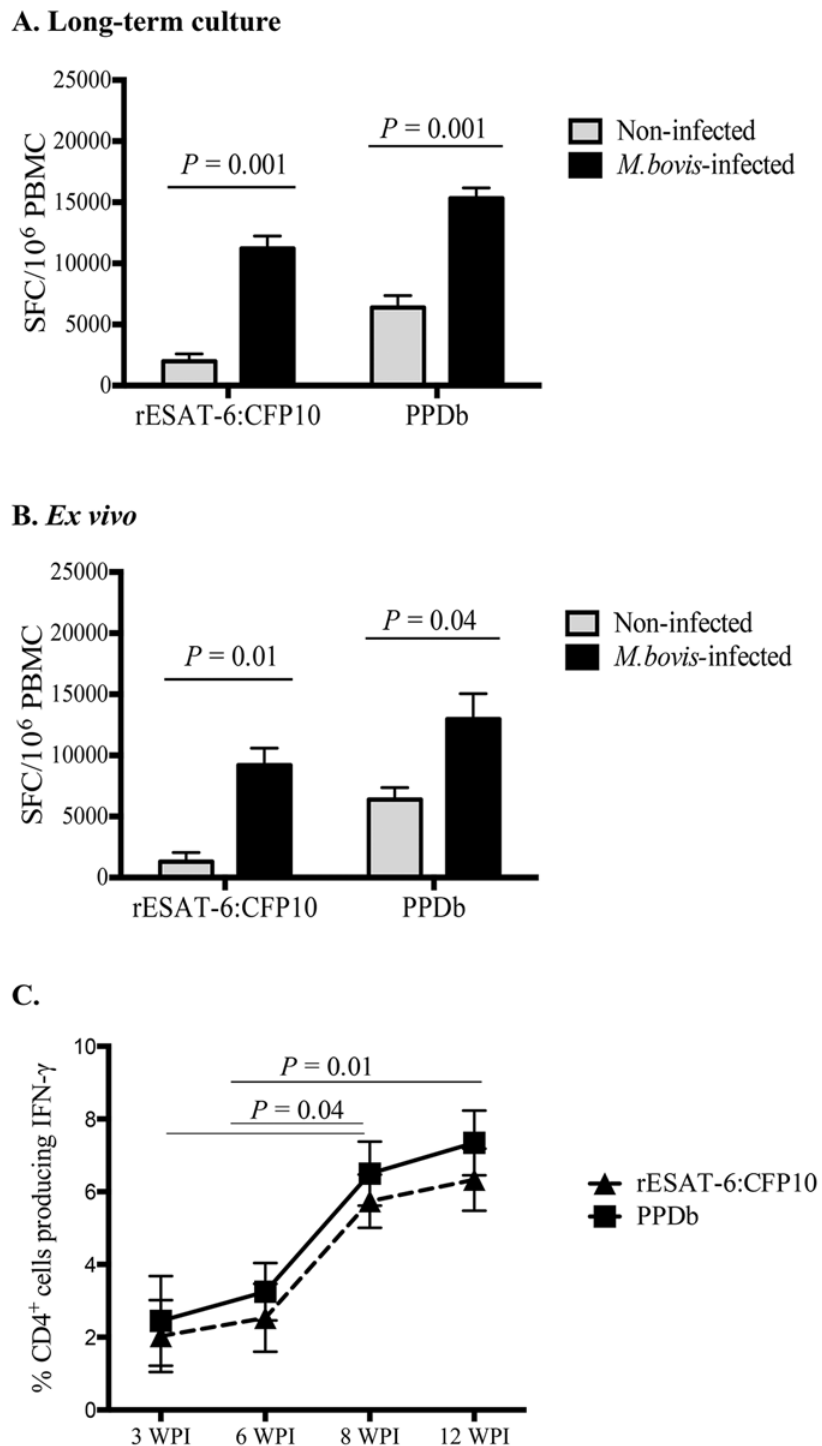
Fig 1. Long-term cultured and ex vivo IFN- γ responses by cattle after M . bovis aerosol challenge. Cultured ELISPOT analysis was performed ~3 weeks after challenge with virulent M . bovis . Long-term cultured cells were generated by stimulating PBMC with a cocktail of rAg85A (1 μ g/ml), rTB10.4 (1 μ g/ml), and rESAT-6:CFP10 (1 μ g/ml) antigens as well as PPDb (5 μ g/ml) for 13 days followed by transfer to ELISPOT plates with APCs and addition of either rESAT-6:CFP10, PPDb or medium alone. For the ex